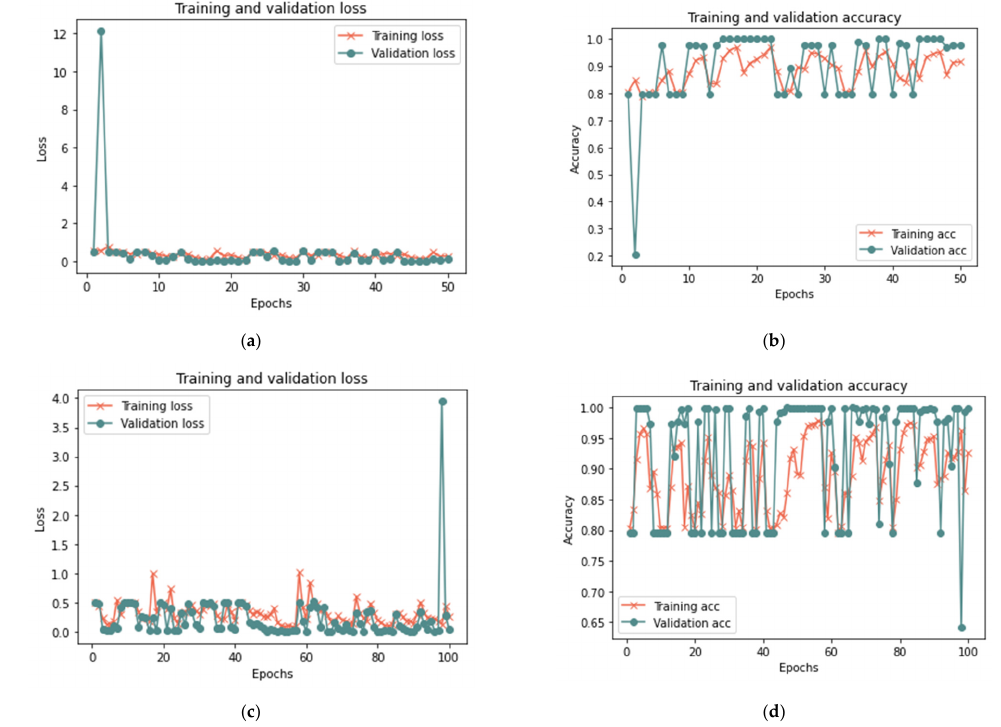
Figure 10. Results of the first scenario with 25% sample size: ( a ) loss at 50 iterations; ( b ) accuracy at 50 iterations; ( c ) loss at 100 iterations; and ( d ) accuracy at 100 iterations.